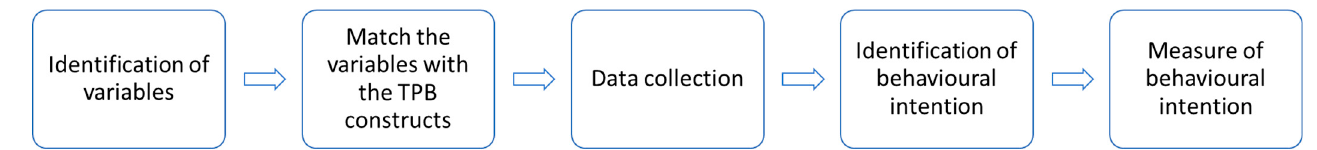
Figure 1. The steps of the research approach.